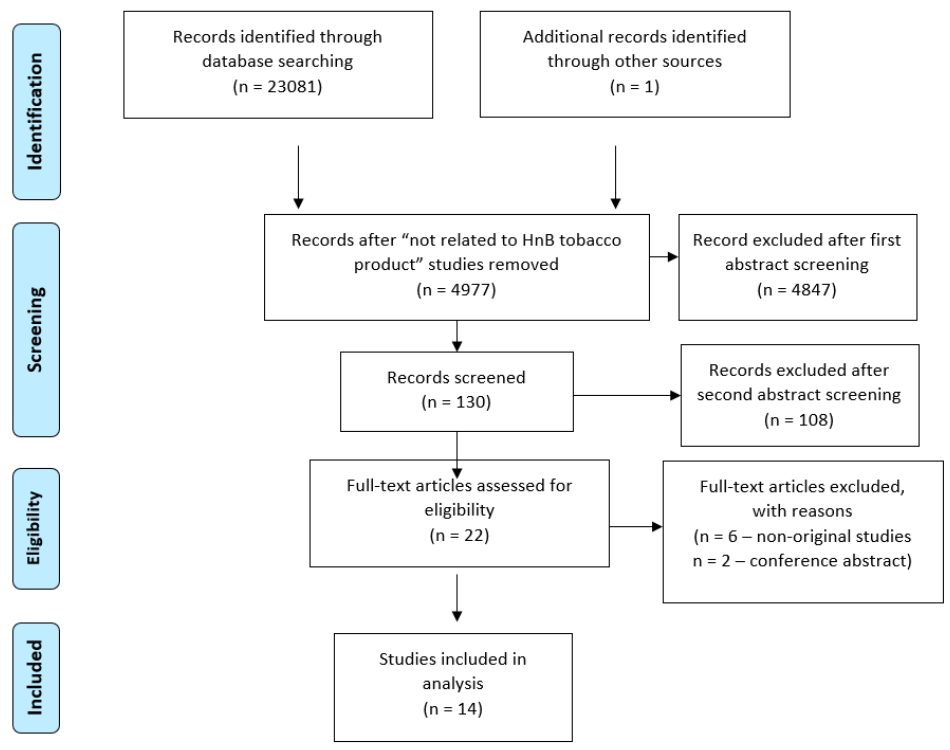
Figure 1. Public health issues.